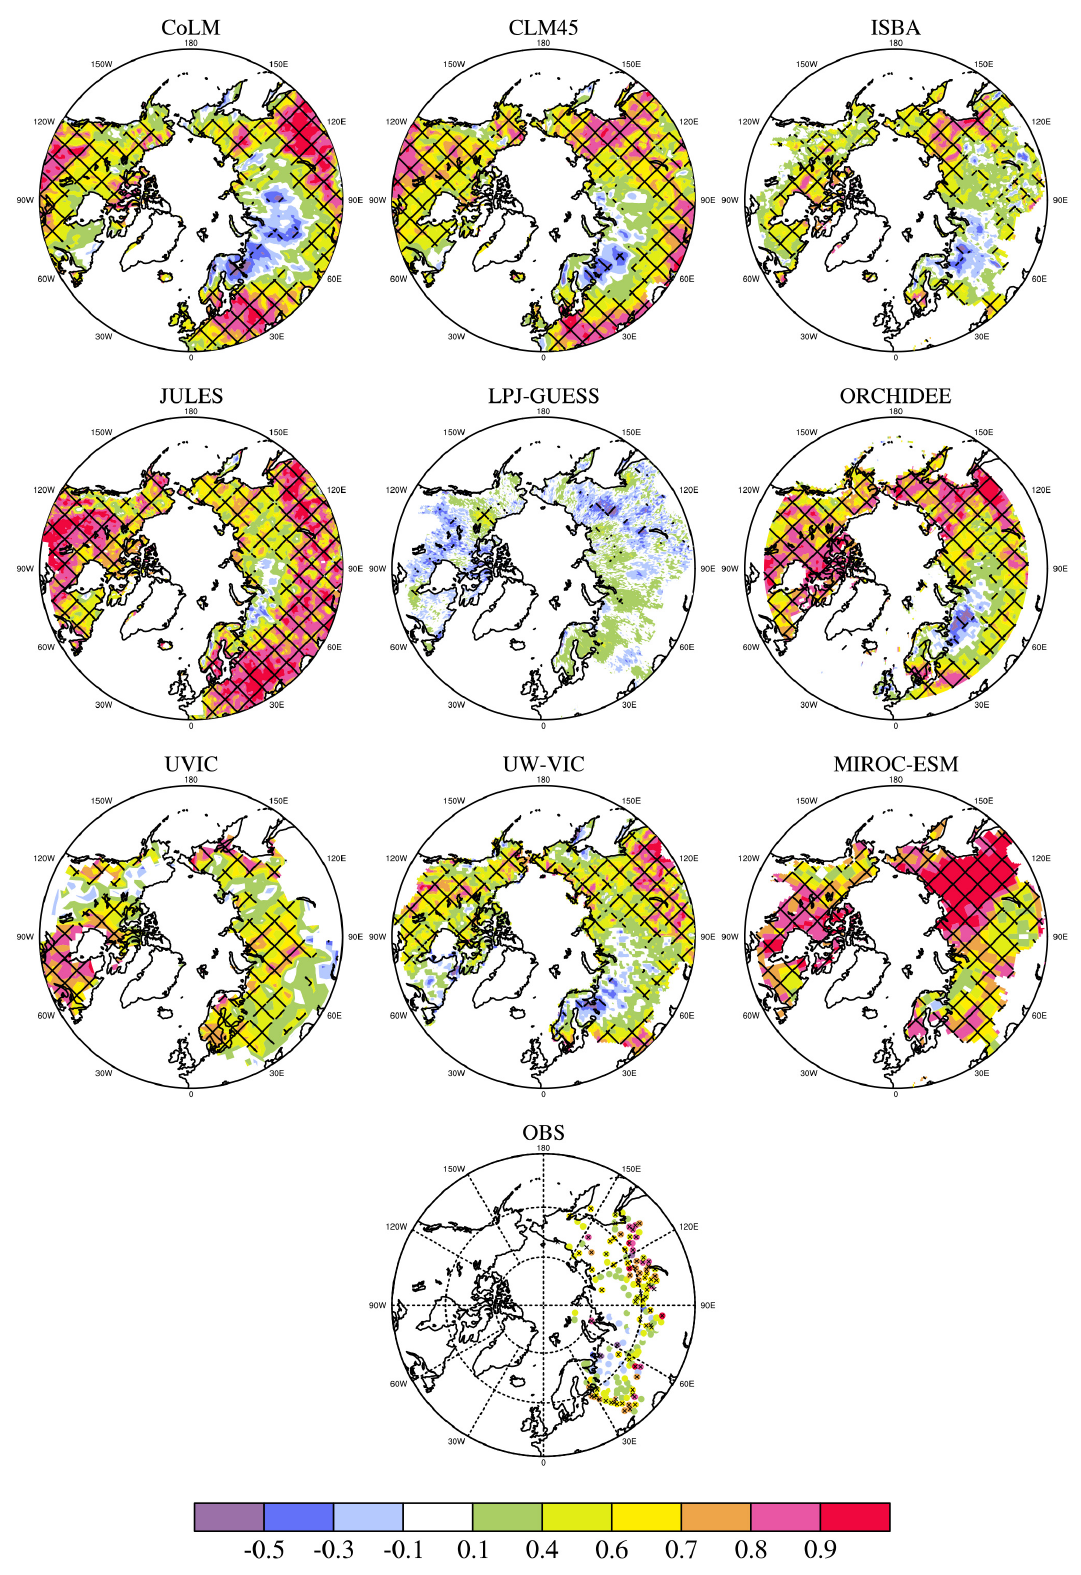
Figure 3. Spatial maps of the correlation coefficients between snow depth and (cid:49)T , the difference between soil temperature at 20cm depth and air temperature for winter 1980–2000. Regions with greater than 95% significance are